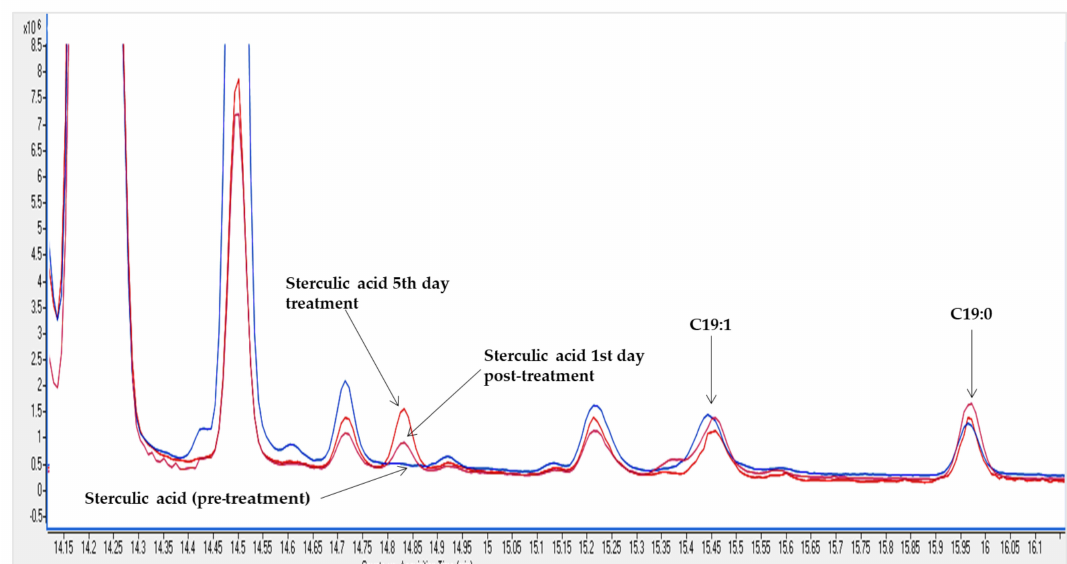
Figure 4. Expanded view of overlaid chromatograms showing the elution zone of sterculic acid, C19:1 and C19:0 methyl esters obtained by GC-MS analysis of ewe milk fat according to the method described by Caligiani et al. [17]. Pre-treatment fat sample (blue) resulted negative to sterculic acid (no signal), whereas sterculic acid was detected at 5th day of treatment (red) and 1st day post-treatment (purple).